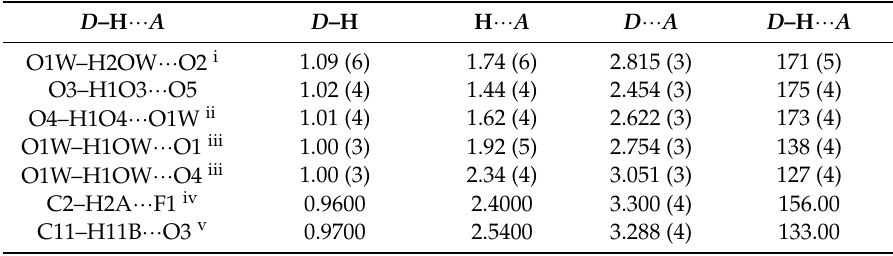
Table 3. Hydrogen-bond geometry (Å, ◦